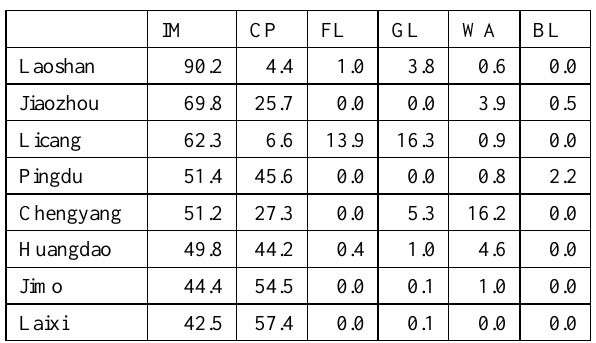
Table 5 . The area proportions(%) of different land cover types